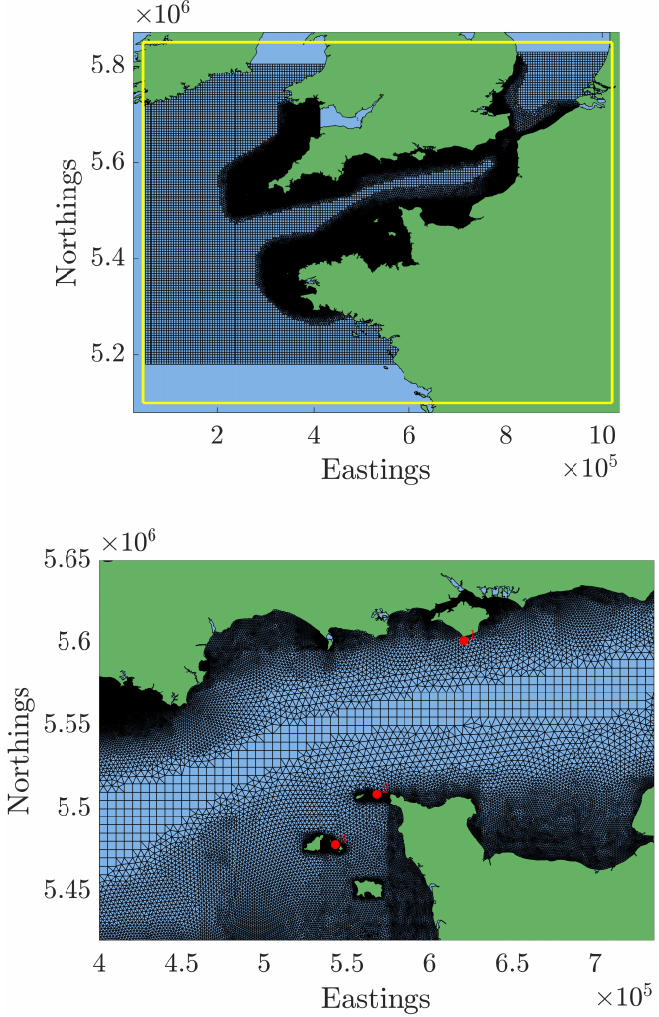
Figure 1. The D-Flow FM computational mesh: ( top ) the entire grid; and ( bottom ) a subsection of the domain showing the location of the three points of interest: 1, :PTEC; 2, Alderney Race; 3, Guernsey. The extent of the SWAN model domain is shown as the yellow